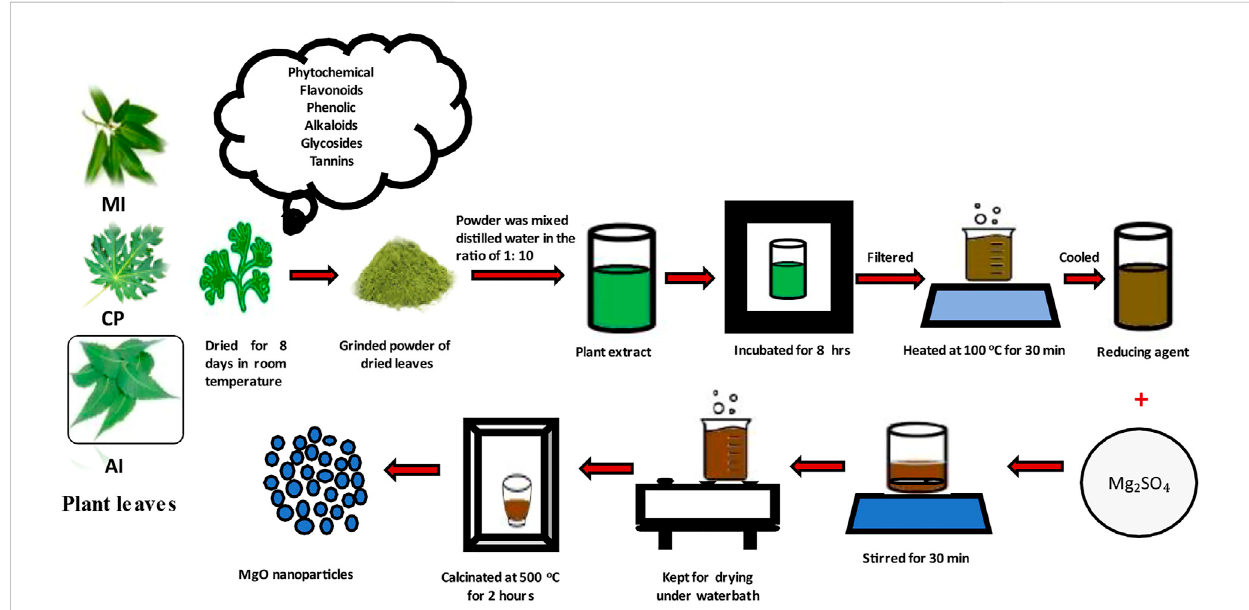
FIGURE 1 Procedure of preparation of magnesium oxide nanoparticles by simple solution